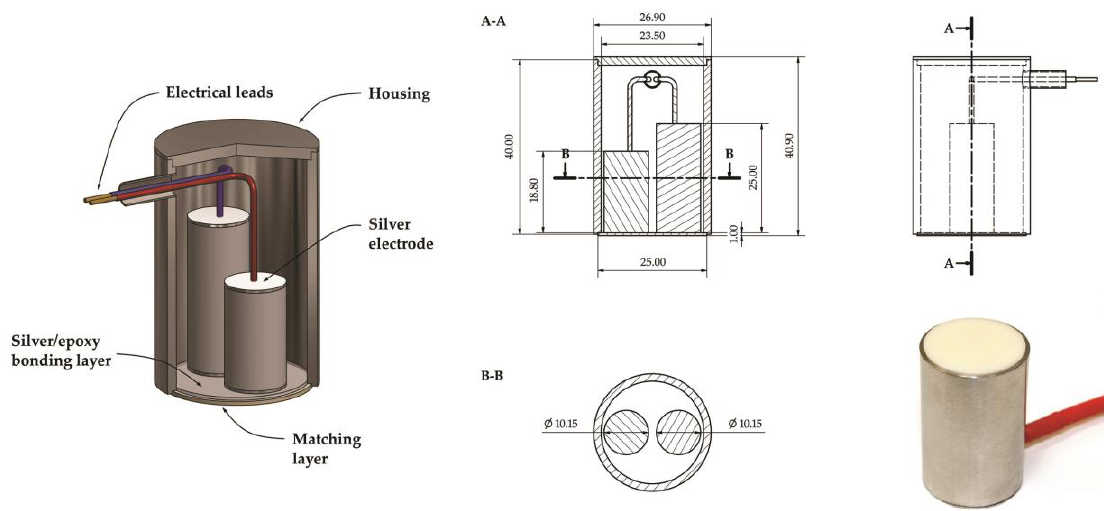
Figure 19. Schematic diagram, technical drawing with dimensions and photo of prototype AE sensor named A6890.